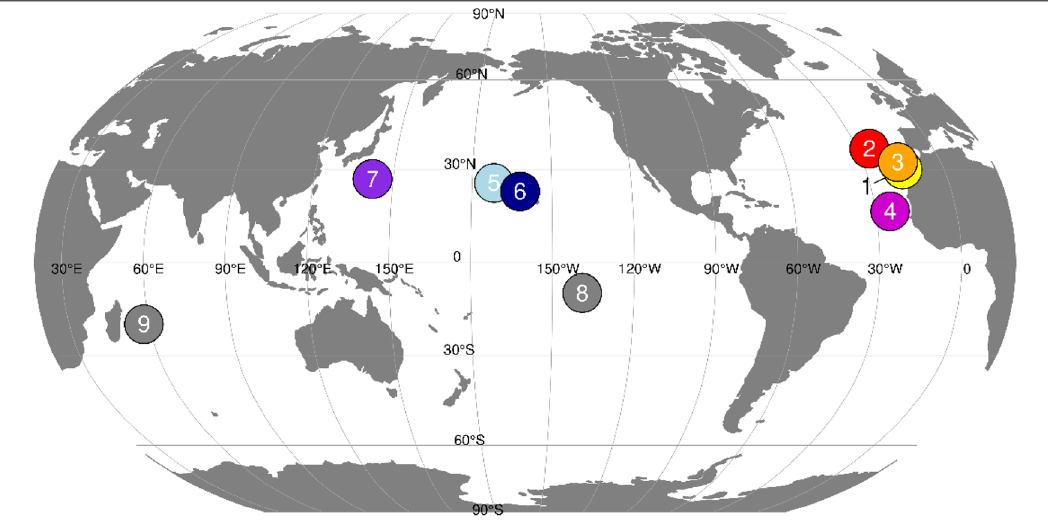
Figure 4. Main breeding areas of Bulwer’s Petrels. In colour are the populations sampled, in light grey are populations not sampled in this study. Sample origin: 1–Selvagem Grande, Selvagens Is., 2—Ilhéu da Vila, Azores; 3–Deserta Grande, Desertas Is; 4–Ilhéu Raso, Cabo Verde; 5–Laysan Is, Hawaii; 6–Nihoa Is, Hawaii; 7— Minamijima Is, Ogasawara Islands; Unsampled: 8–Marquesas Islands; 9–Round Island,